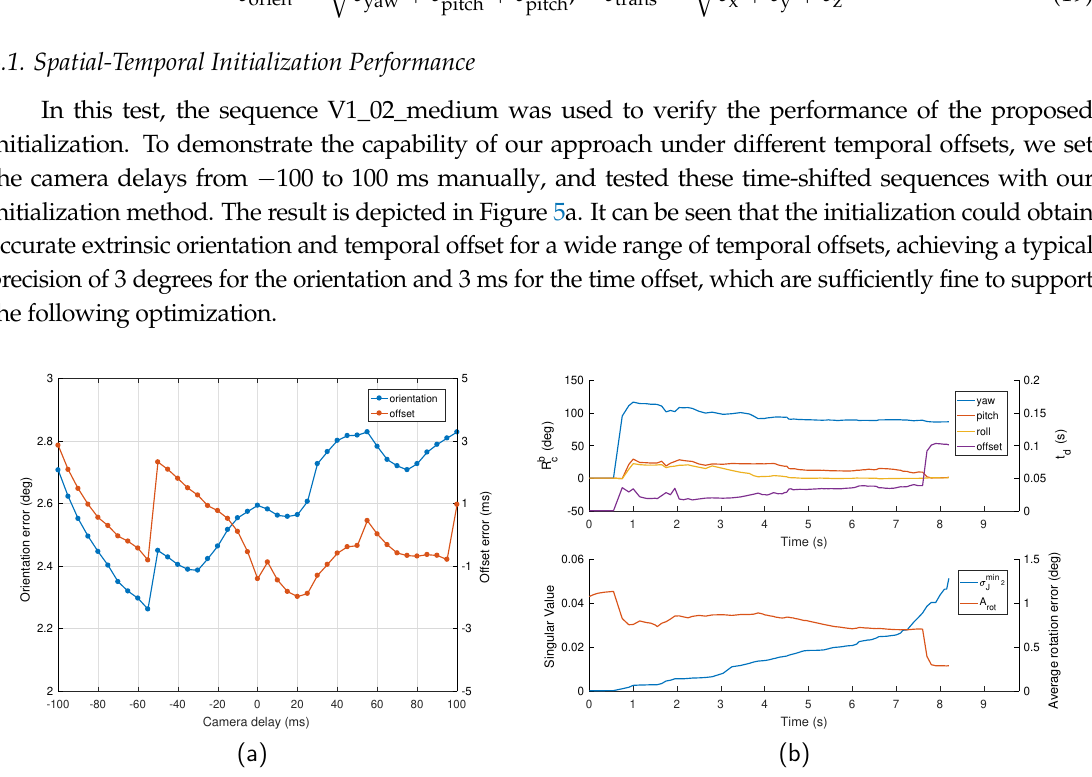
Figure 5. Spatial-temporal initialization results on V1_02_medium. ( a ) The orientation and time offset errors with respect to the different predefined camera delays. All the orientation errors are below three degrees and all the temporal offset errors are lower than 3 ms, which proves our approach is able to recover accurate enough orientation and offset under a wide range of temporal offsets. ( b ) Detailed illustration of the entire initialization process when the camera delay is set to 100 ms. ( Top ) The spatial orientation and time offset estimated. ( Bottom ) The second smallest singular value and the average rotation